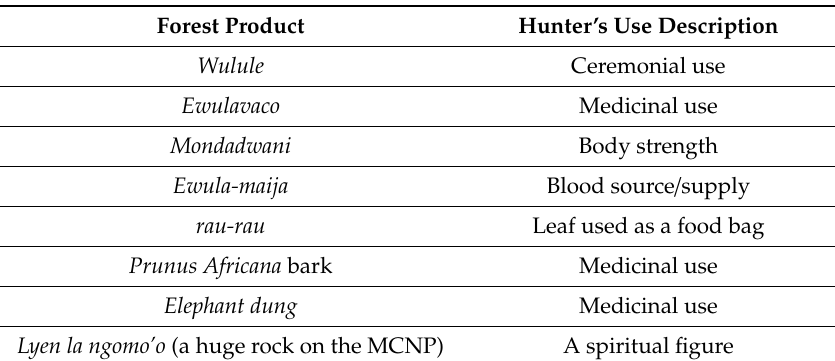
Table 2. Distribution of forest products and their use.